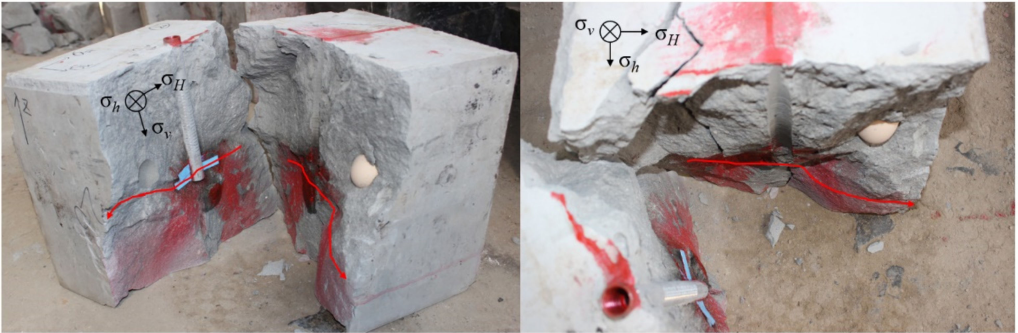
Figure 6. Hydraulic fracture geometry of sample C-4.